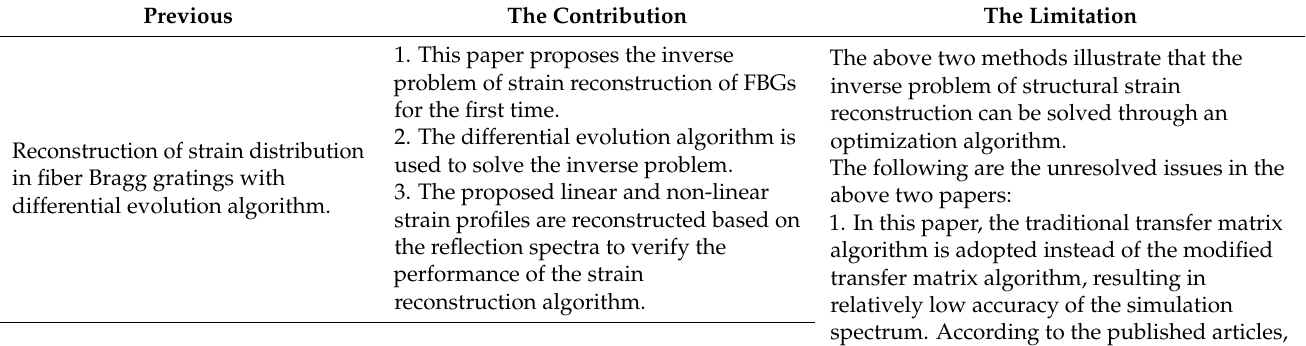
Table A1. The comparative table of our team’s contribution with the previous